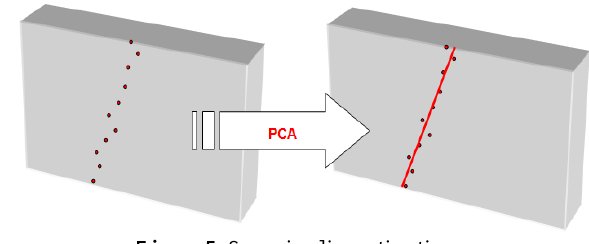
Figure 5 : Scanning line